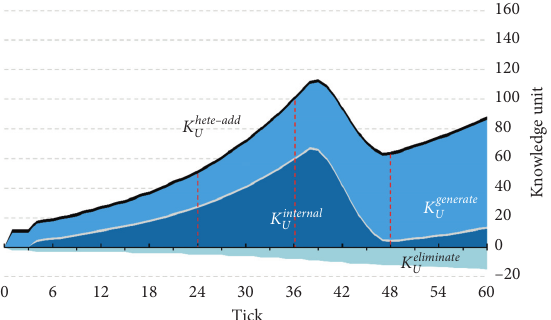
Figure 6: Agent U heterogeneous knowledge increment evolution.